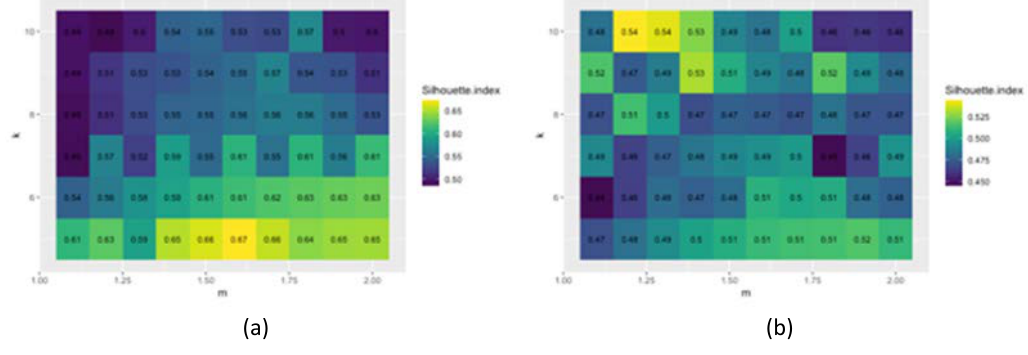
Fig. 2: Scree plot of PCA result (a) wet season; (b) dry season